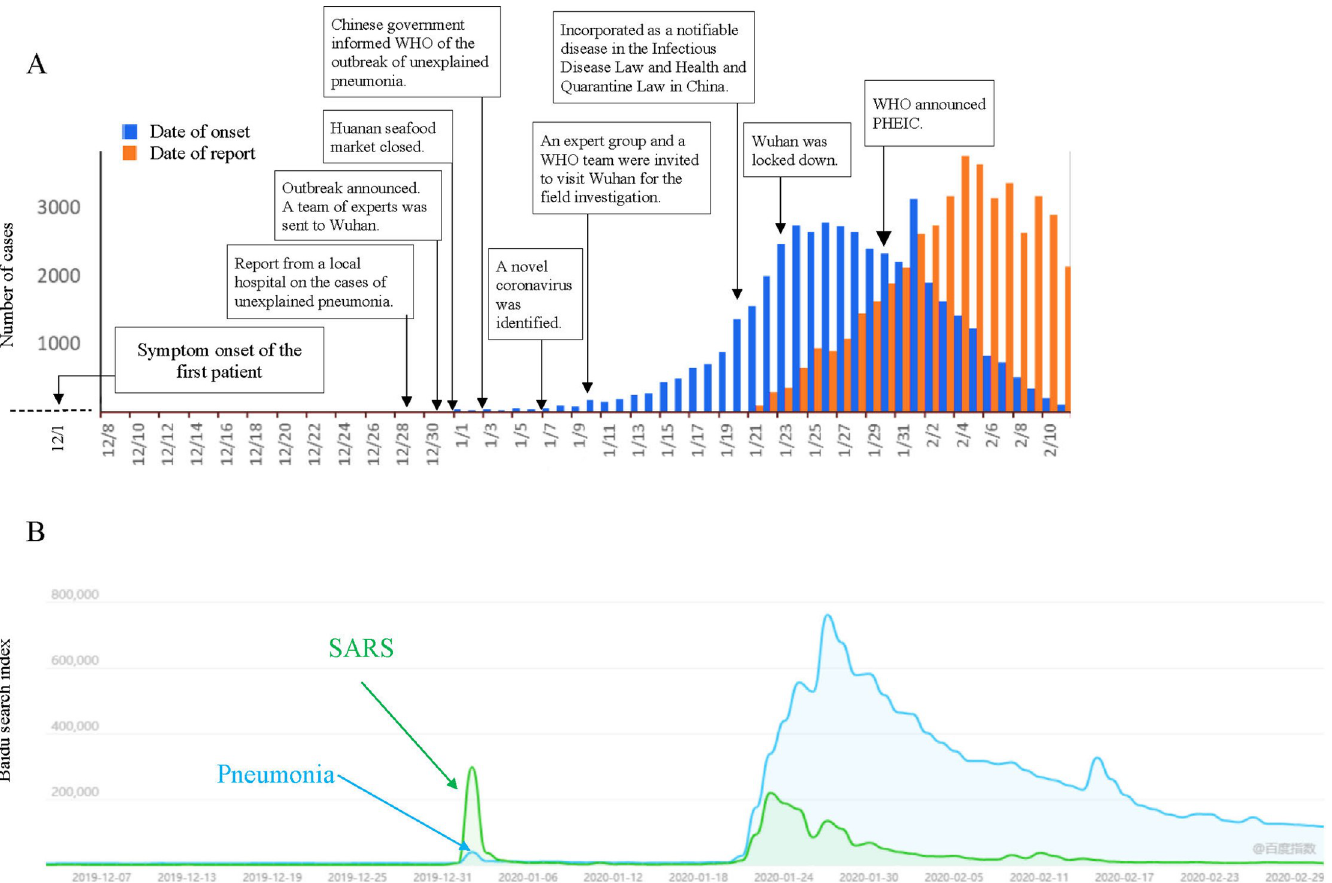
Fig 1. Comparison of the COVID-19 outbreak and Baidu searching index. A. Timeline of the COVID-19 outbreak and official response. Only confirmed cases were analyzed referring to the report by The Novel Coronavirus Pneumonia Emergency Response Epidemiology Team in China. [10] B. The online search index for the terms of “pneumonia” and